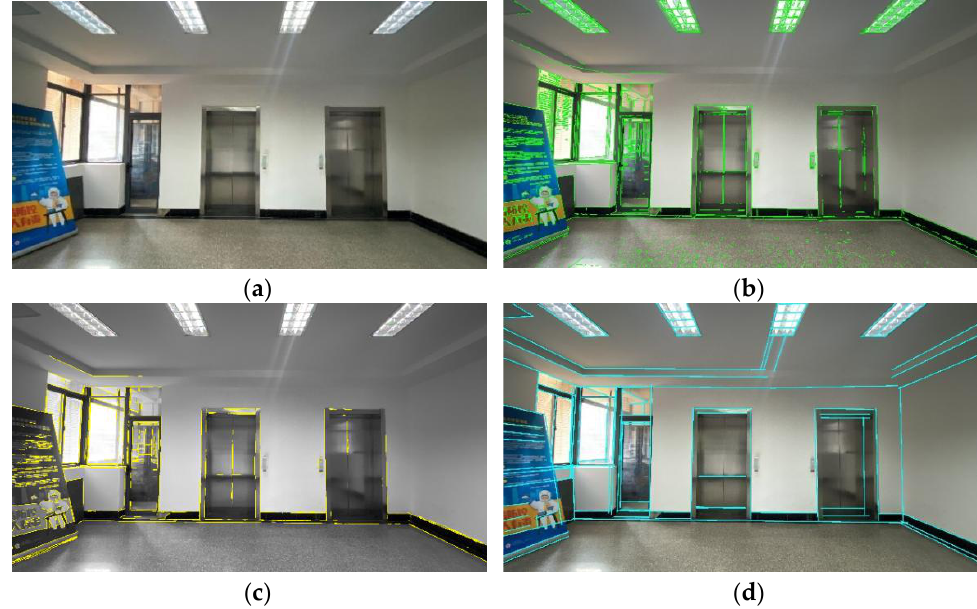
Figure 4. Results of different two-dimensional line segment detection methods: ( a ) the original image; ( b ) LSD; ( c ) ED-line; ( d ) M-LSD.